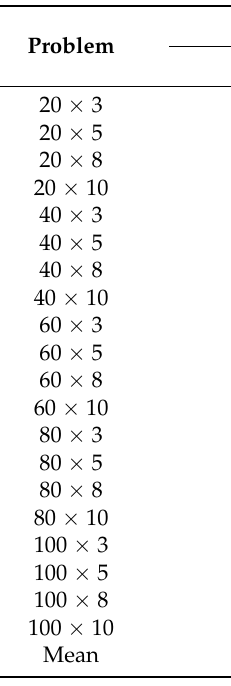
Table 9. C -metric for SDABC and NSGAII.